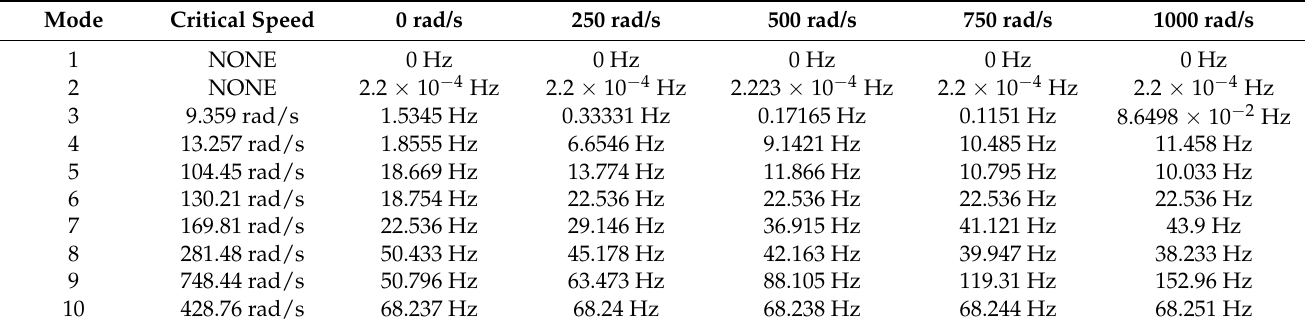
Figure 5. Campbell diagram. Table 6. The first ten natural frequencies and critical